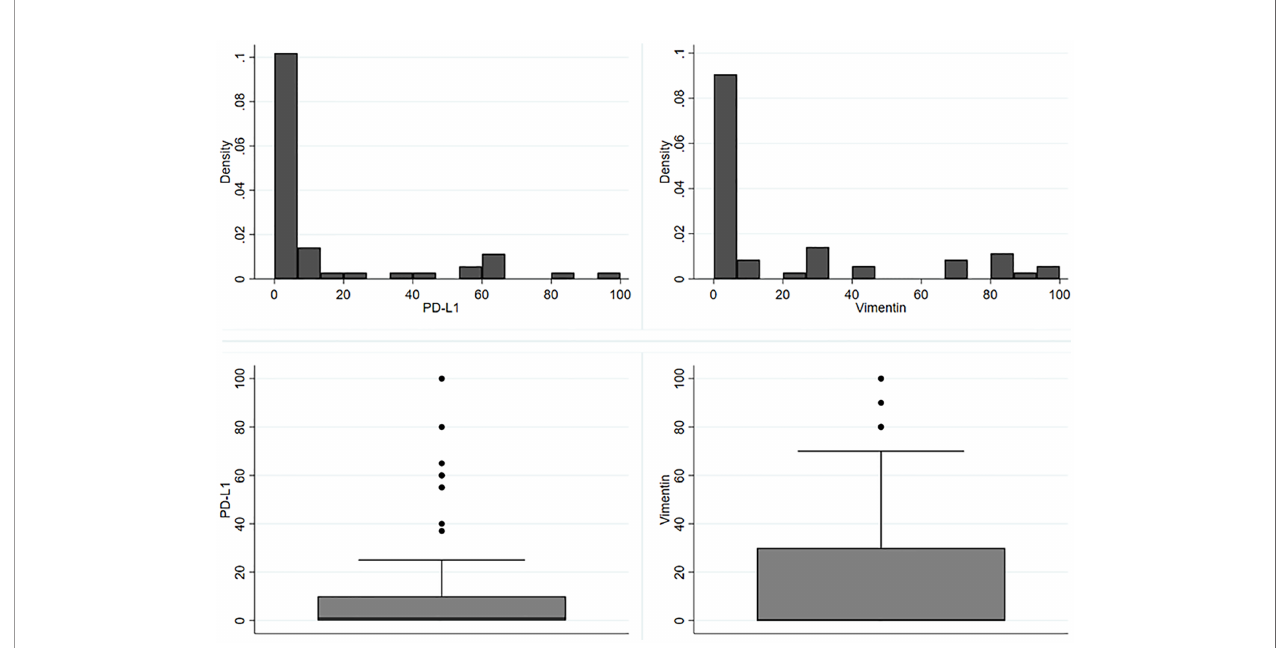
FIGURE 2 | Expression value distribution for PD-L1 and vimentin.